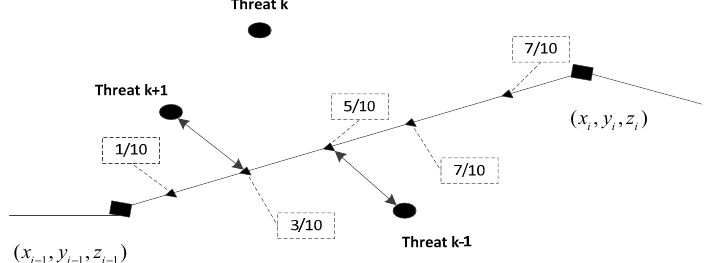
Figure 1. The image of threat computation model.